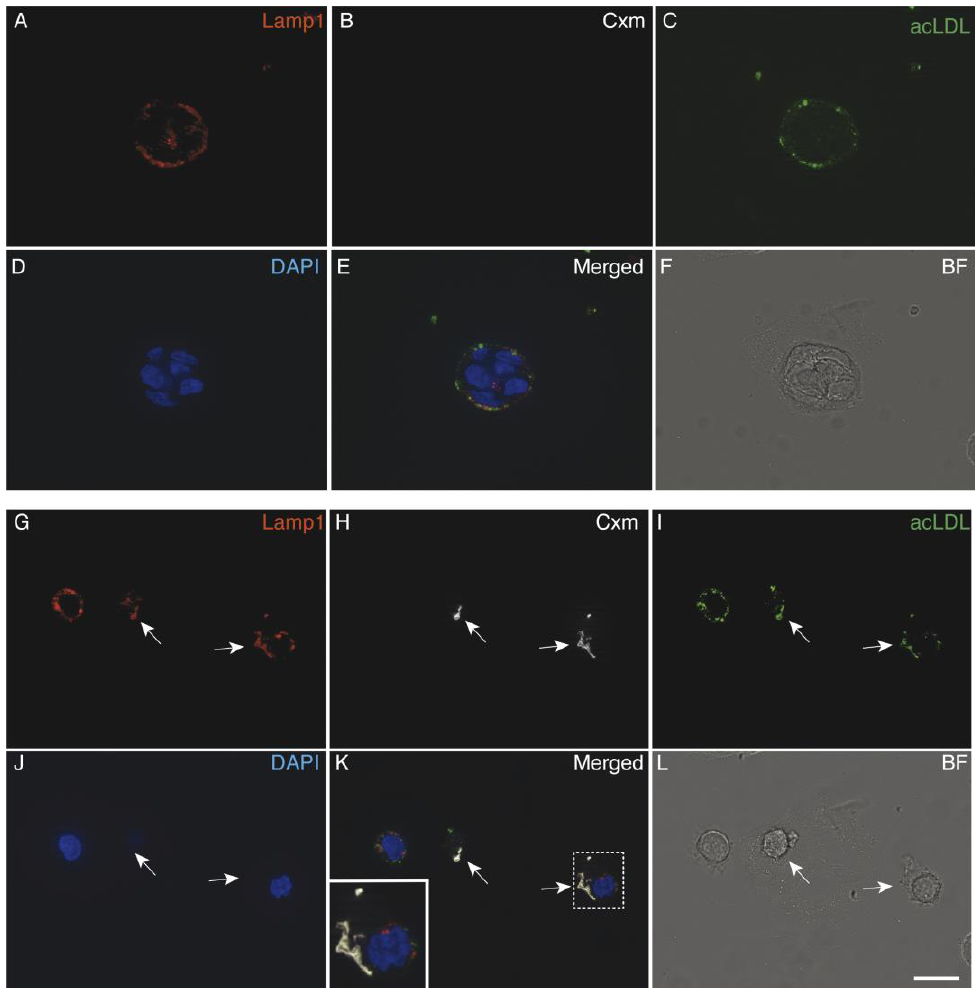
Figure 6. Cxm-Liposomes are endocytosed and trafficked to the endo/lysosomal compartment . Immunofluorescence analysis of the Caco-2 cell line treated for 2 h with a PBS control ( A – F ) or with Cxm-LLNle ( G – L ) and acLDL. Anti LAMP1 Ab and DAPI were used to detect lysosomes and nuclei, respectively. Arrows point to regions of colocalization of LAMP1, Cxm and acLDL signals. In the boxed area is shown a digitally enlarged area of triple colocalization. A single channel along with merged and bright-field images are shown. Bar = 20 µm .